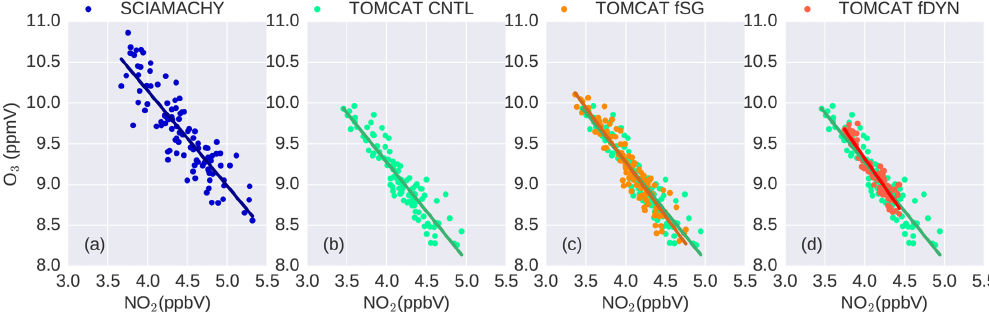
Figure 5. NO 2 –O 3 scatter plots in the tropical stratosphere at an altitude of 31.5km from (a) SCIAMACHY and TOMCAT simulations (b) CNTL, (c) CNTL and fSG, and (d) CNTL and fDYN. Colour coding denotes data source: SCIAMACHY (dark blue), TOMCAT: CNTL (green), fSG (orange), and fDYN (red). Solid lines specify linear fits to the data points.